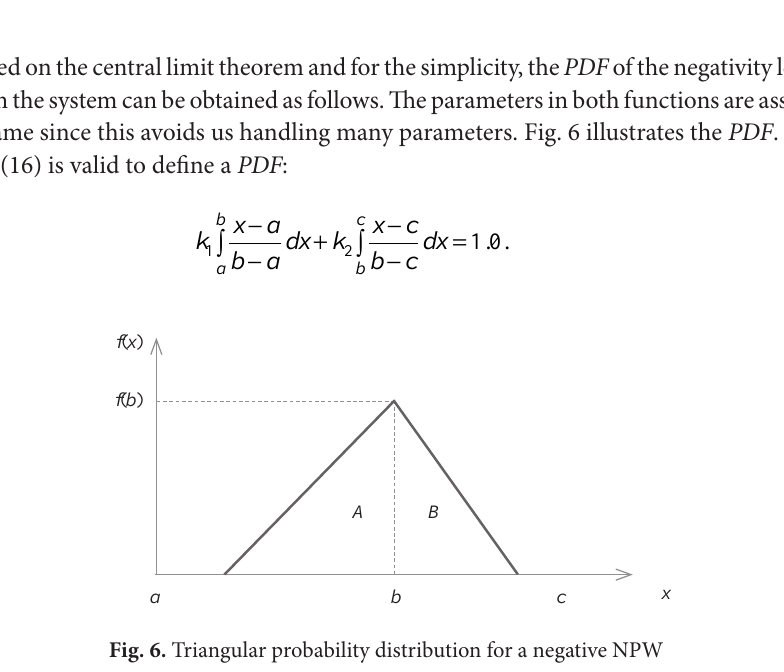
Fig. 5. Membership function of the fuzzy set of a negative NPW